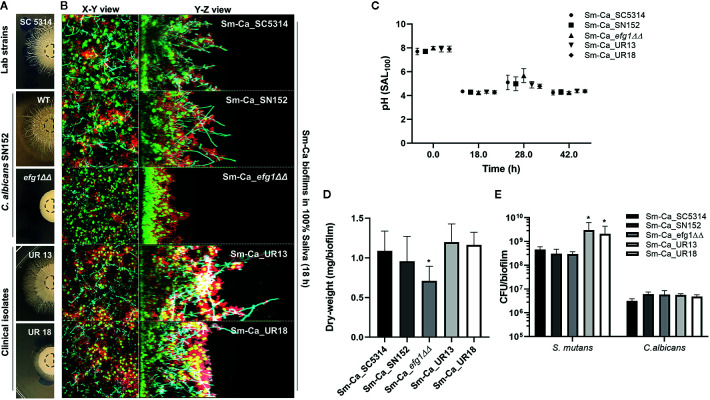
Effect of hyphal transformation ability on the properties of Sm-Ca biofilms in saliva. (A)
C. albicans colonies of SC5314, SN152, efg1ΔΔ, UR13, and UR18 strains on Spider agar plate. Morphology of fungal colony was photographed after incubation for 4 days at 37°C. (B) Representative top (X–Y) and orthogonal (Y–Z) views of confocal images of each mixed-species biofilm under SAL100 at 18 h. Bacterial cells are labeled with SYTO 9 (green), fungal cells with concanavalin A-tetramethylrhodamine (Cyan), and EPS α-glucan with Alexa Fluor 647 (red). (C) pH value at each time point (18, 28, and 42 h). Data were analyzed by descriptive analysis and one-way analysis of variance (ANOVA) using GraphPad Prism 8. (D) Total biomass (dry weight) of each Sm-Ca biofilm and (E) CFU of S. mutans and C. albicans at the endpoint (42 h). Asterisk indicates that the p-values are significantly different from wild type biofilm (Sm-Ca_SC5314) (ANOVA with Dunnett; *P < 0.05).